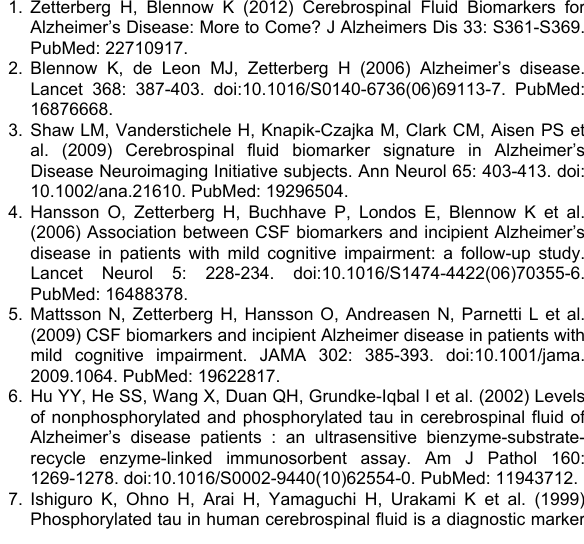
Table S2. Tau ELISA correlations. Table S3. Analysis of ptau assay ratios in 20 x 20 sample set. Table S4. Complete demographic information for 20 x 20 sample set. Table S5. Individual data for 20 x 20 sample